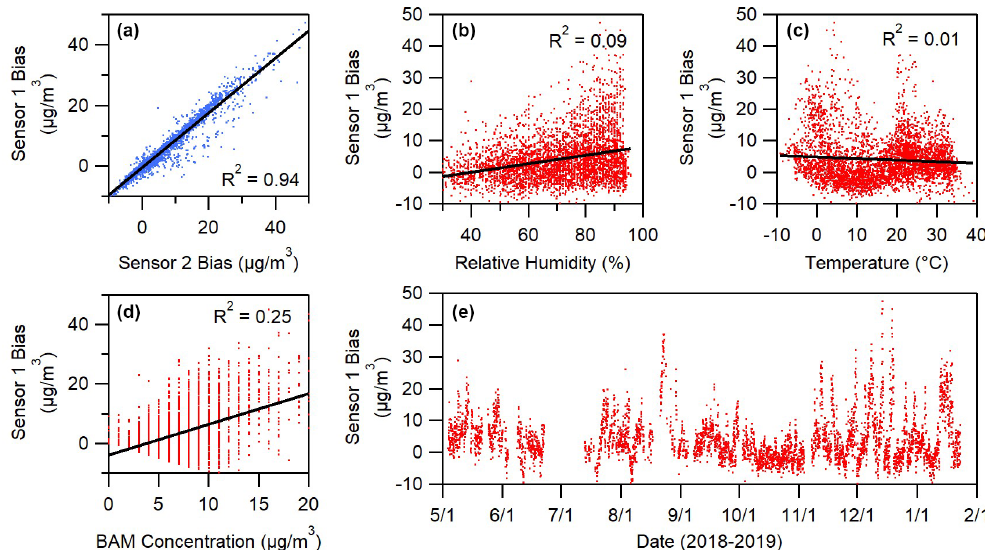
Figure 2. Panel (a) shows the correlation between the bias ( C sensor − C reference ) of two sensor replicas. Panels (b) – (d) show correlation between sensor bias and meteorological factors. Panel (e) shows that bias varies over time but not in a consistent pattern. Measurement gaps in (e) are the result of the BAM not meeting its internal relative humidity specification